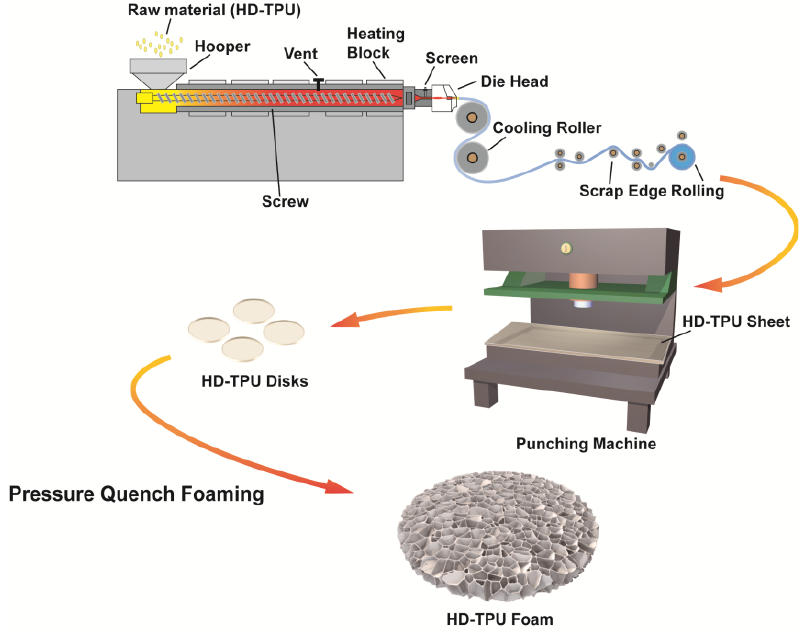
Figure 15. Schematic diagram of the preparation process of HD-TPU foams.